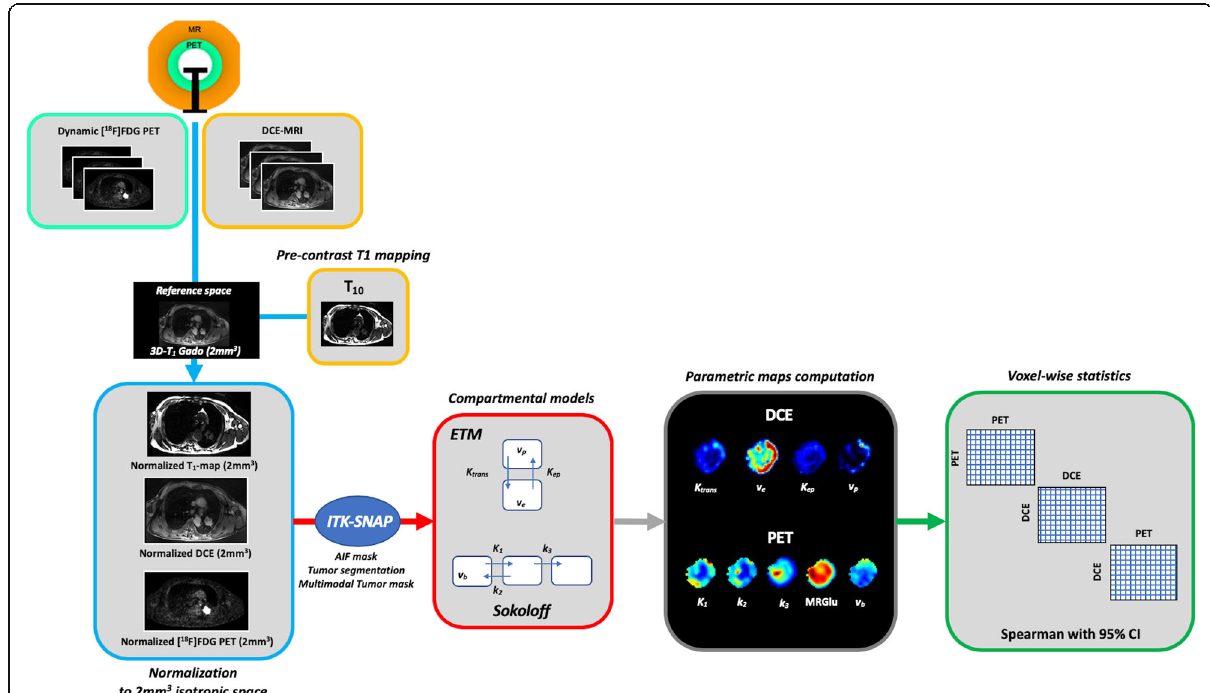
Fig. 1 Study workflow. ETM, extended Tofts